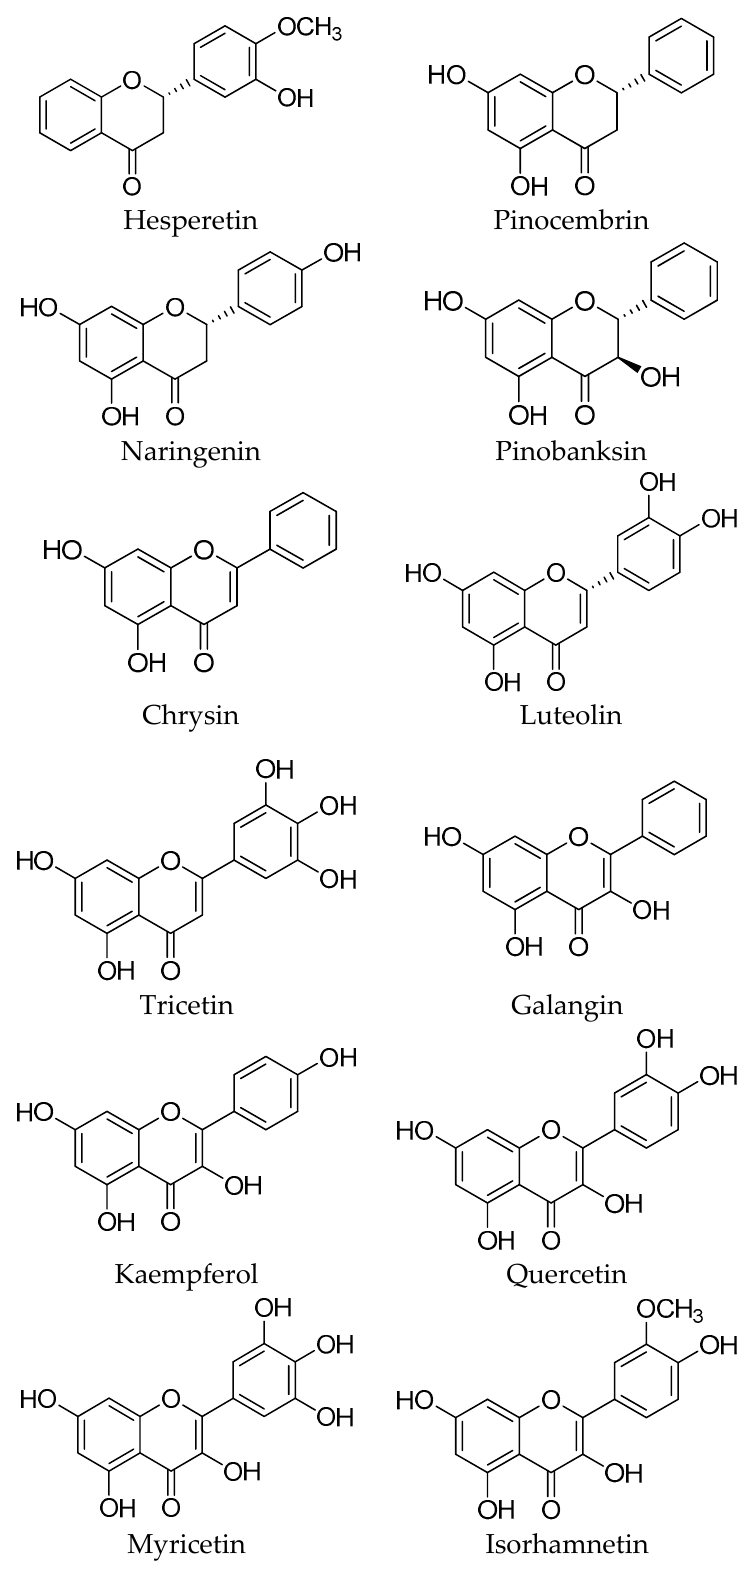
Figure 3. Most significant flavonoids in honey.